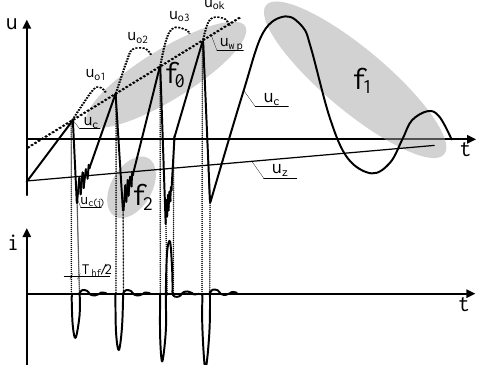
Figure 2. Characteristic waveforms of the network voltage u z , voltage u c on the switched-off transformer, and the recovery dielectric strength of the circuit breaker u wp as well as the waveform of the current and the vacuum circuit breaker [15,16].